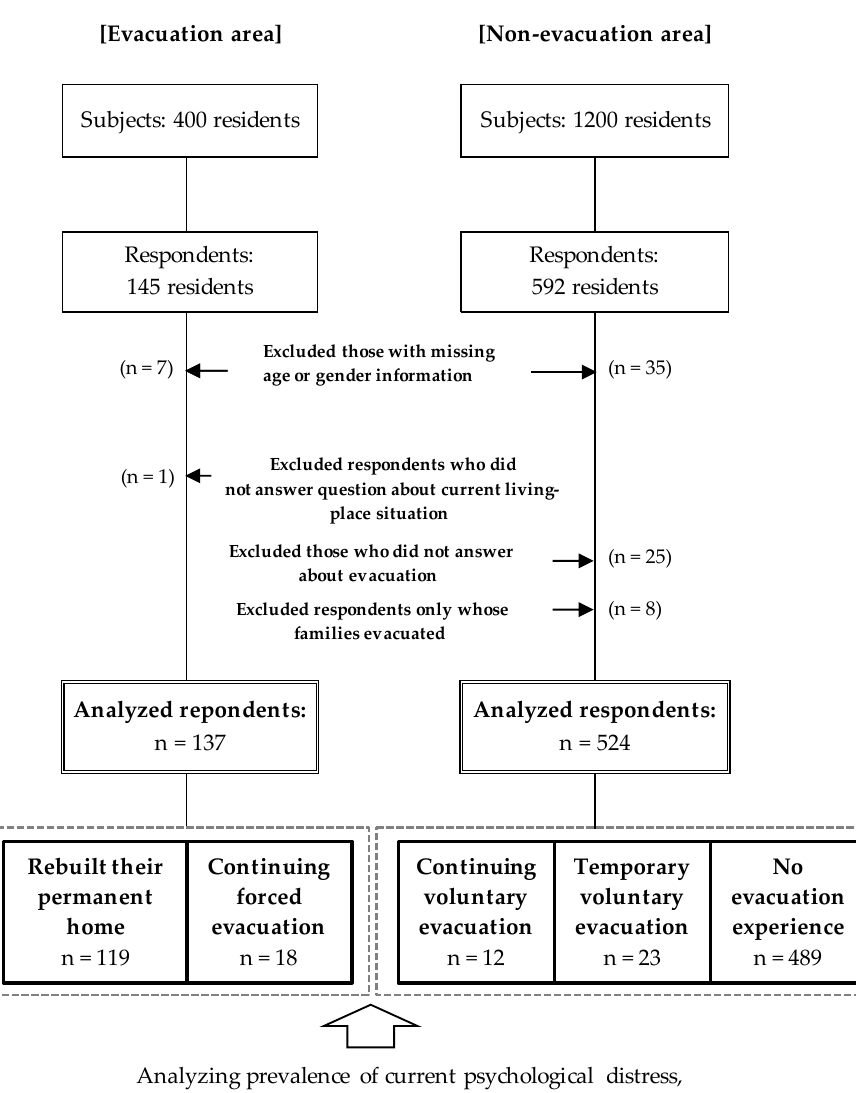
Figure 3. Sample selection for the evacuation and non-evacuation areas and the classification of the current evacuation situation. There are 137 subjects among residents in the evacuation area and 524 residents in the non-evacuation area. These subjects are classified into the five categories shown above.